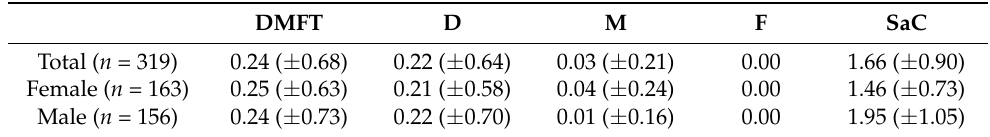
Table 1. Mean values of the Decayed, Missing and Filled Teeth (DMFT) parameters and the Specific affected Caries Index